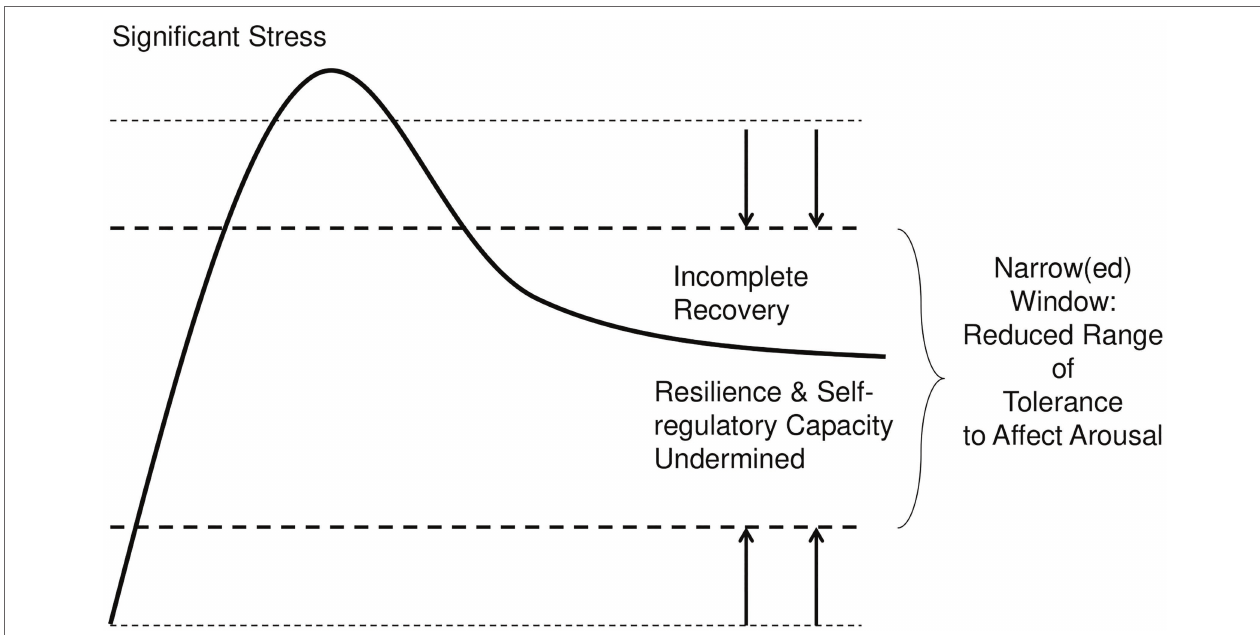
FIGURE 2 | Narrowing the Window through Incomplete Recovery. This figure depicts how individuals can narrow their neurobiological window of tolerance to affect arousal. Their window can narrow via three pathways when they accumulate allostatic load without adequate recovery. The narrower their window, the more likely during challenges that System 2 processes will be operating in a degraded manner while System 1 processes drive decision-making and